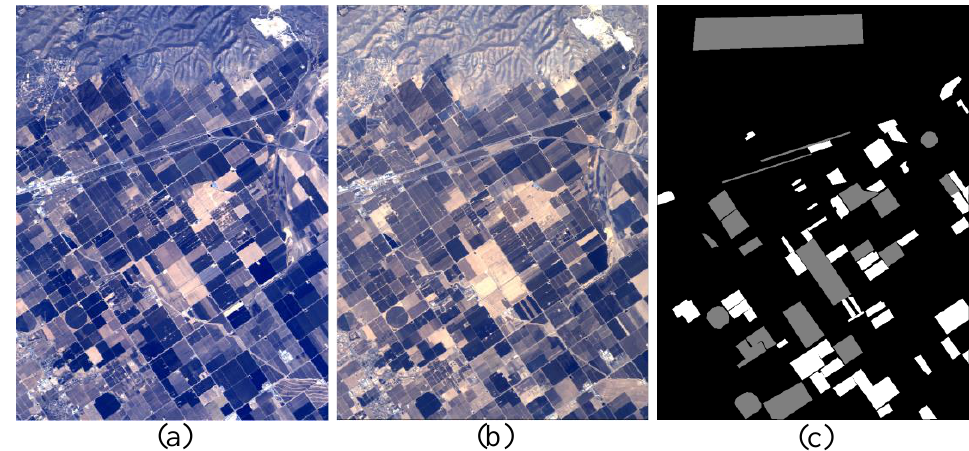
Figure 2. Barbara dataset: ( a ) T 1 -time image, ( b ) T 2 -time image, and ( c ) reference image. (Notation: gray color, white color, and black color denote unchanged pixels, changed pixels, and uninteresting pixels,